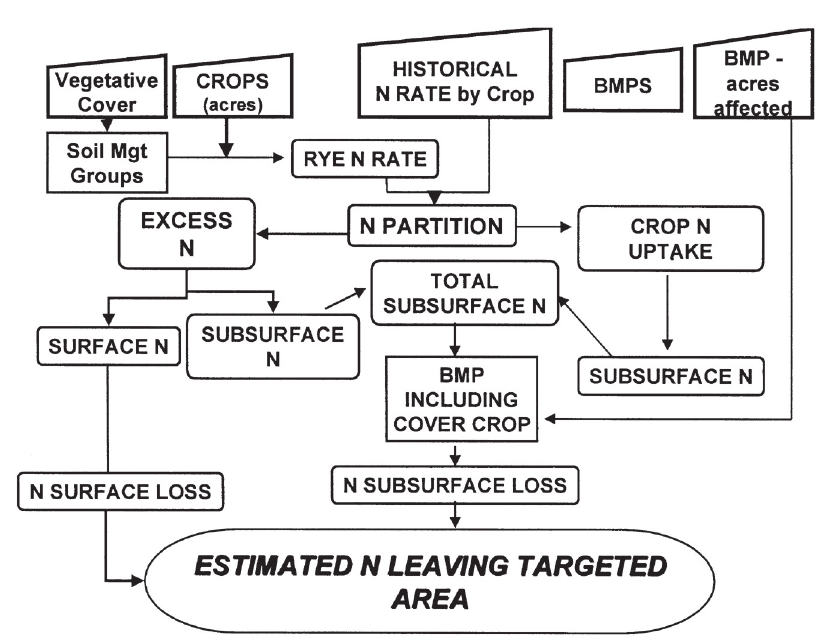
FIGURE 2 . Schematic of aggregate